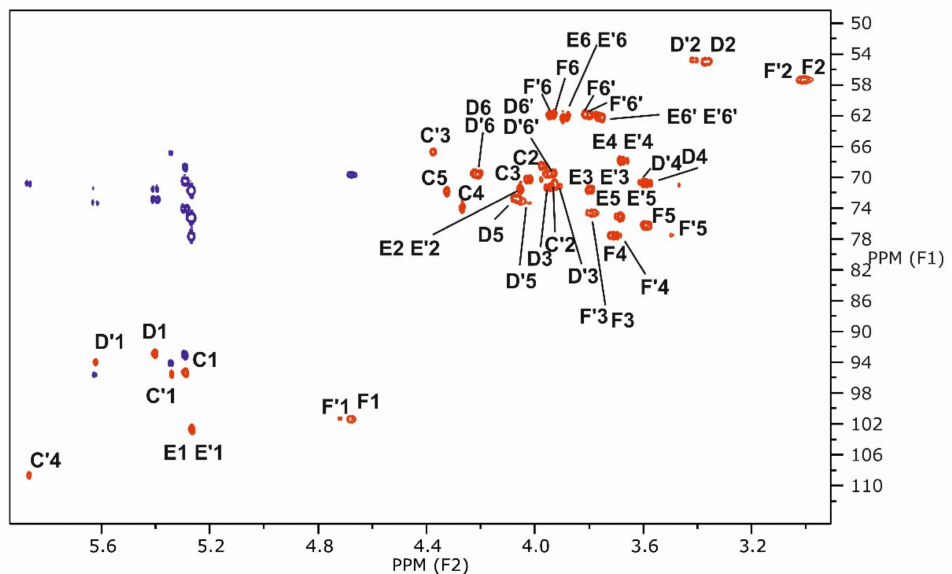
Figure 7. Part of the 1 H, 13 C HSQC (red) and 1 H, 13 C HMBC (dark blue, only anomeric region) spectra of tetrasaccharides obtained after mild hydrazinolysis and hot KOH treatment of lipid A from LPS of Rv . Only HSQC signals from backbone sugar residues are